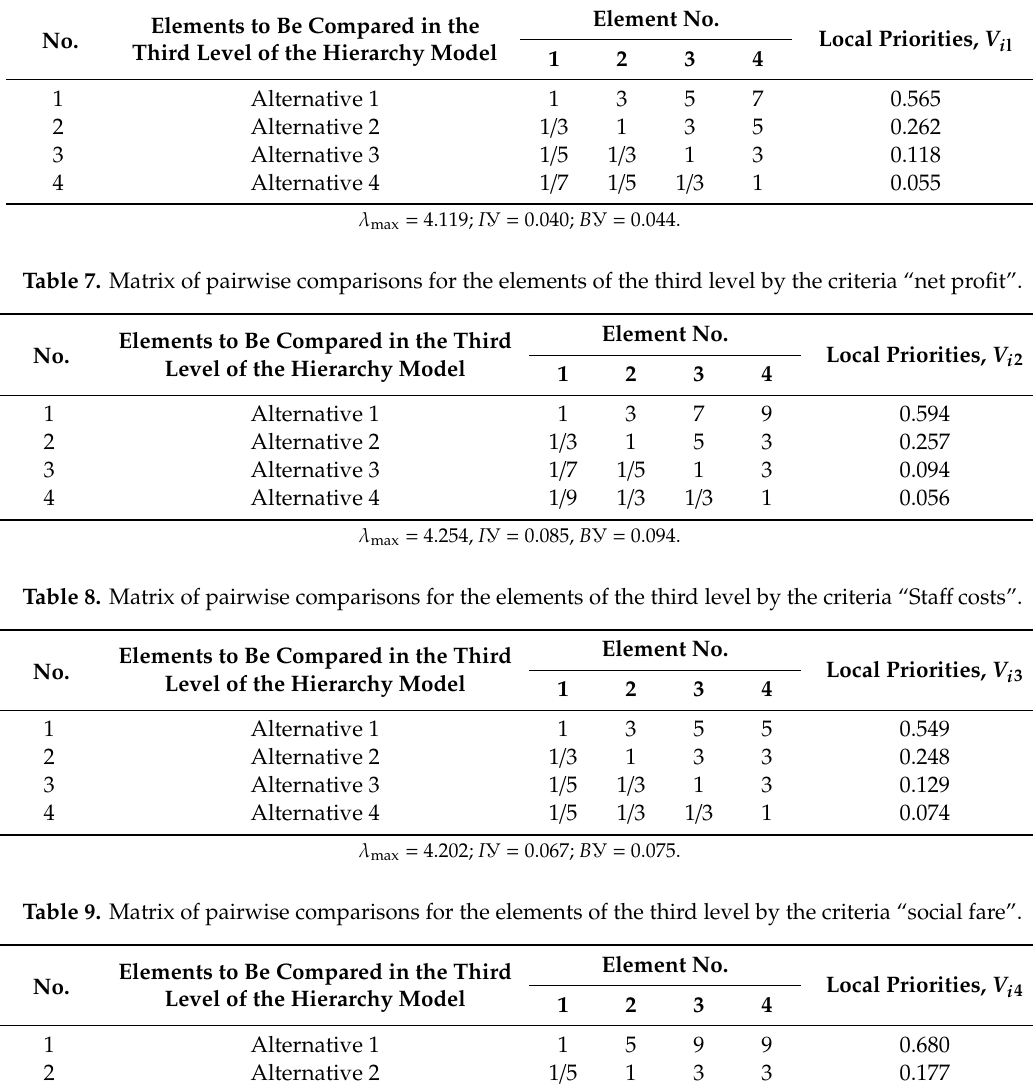
Element No. Local Priorities, V i l 1